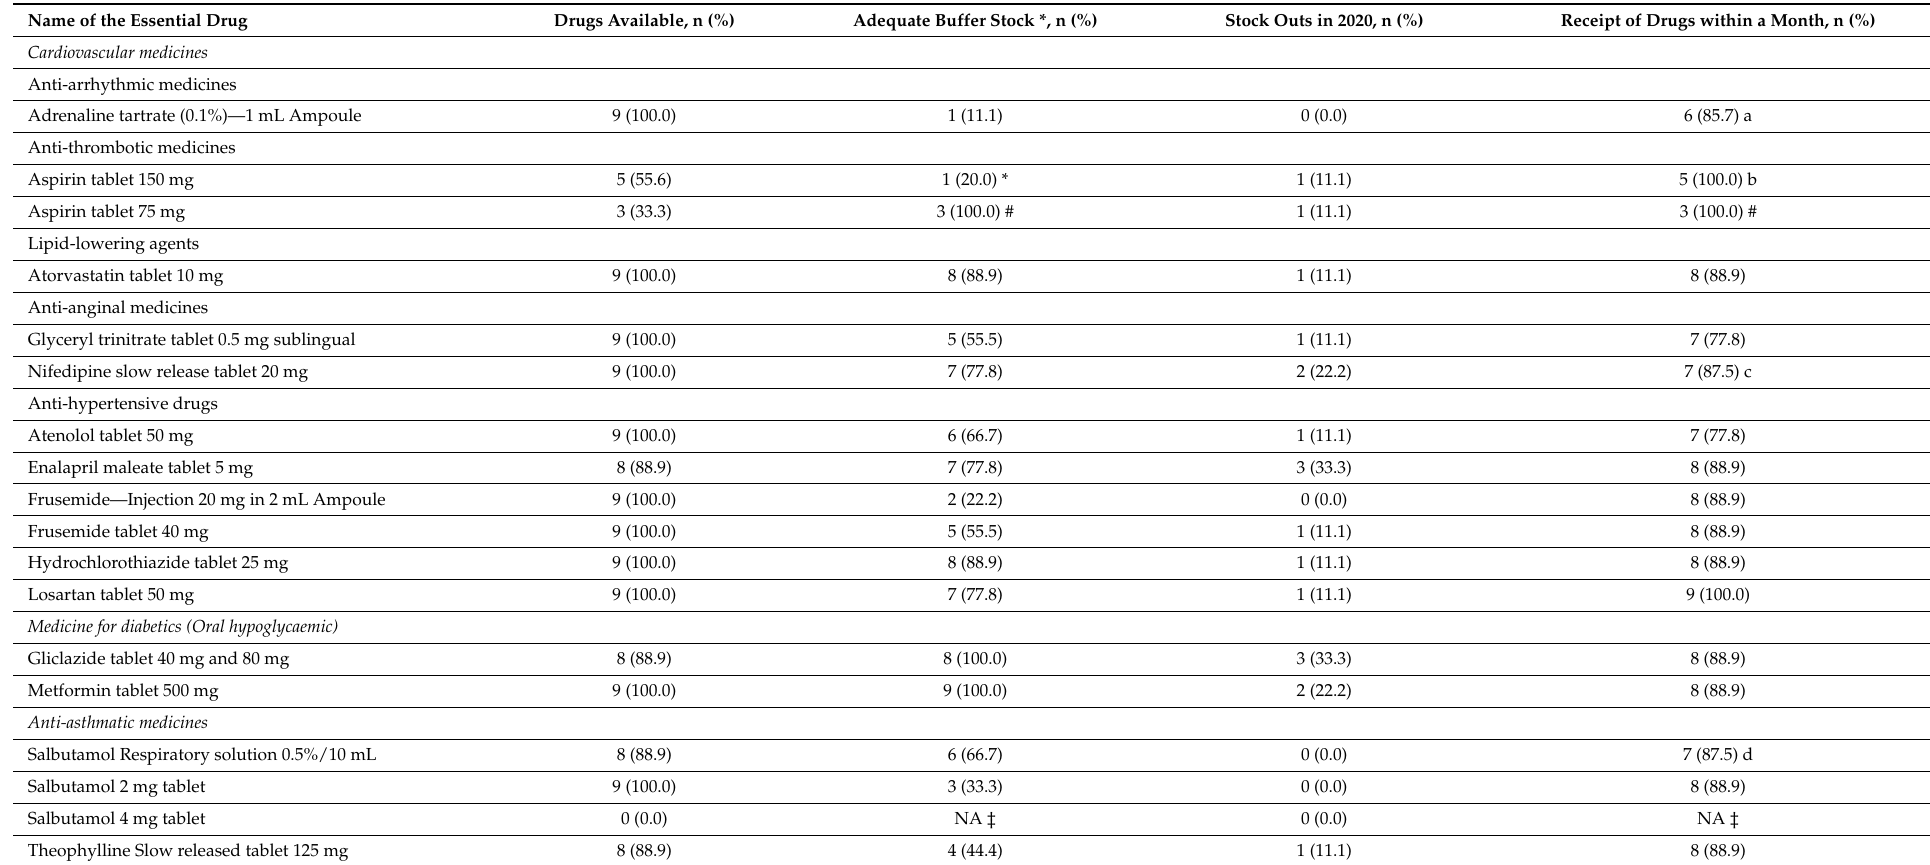
Table 1. Availability of essential drugs, stock outs and receipt of drugs within a month of indenting in the nine selected PMCIs supported by the Primary Healthcare-System-Strengthening Project (PSSP) in Sri Lanka in